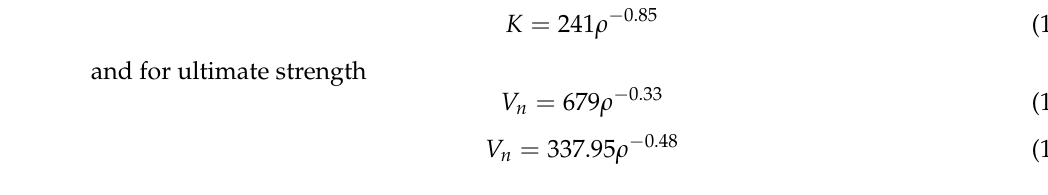
Table 4. The structural parameters of LYP damper divided by A36 damper.